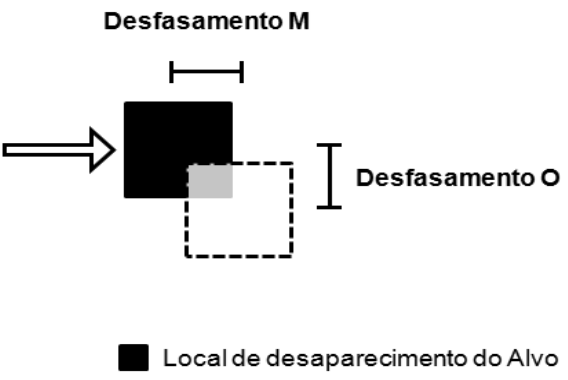
Figura 1 . Componentes dimensionais do desfasamento